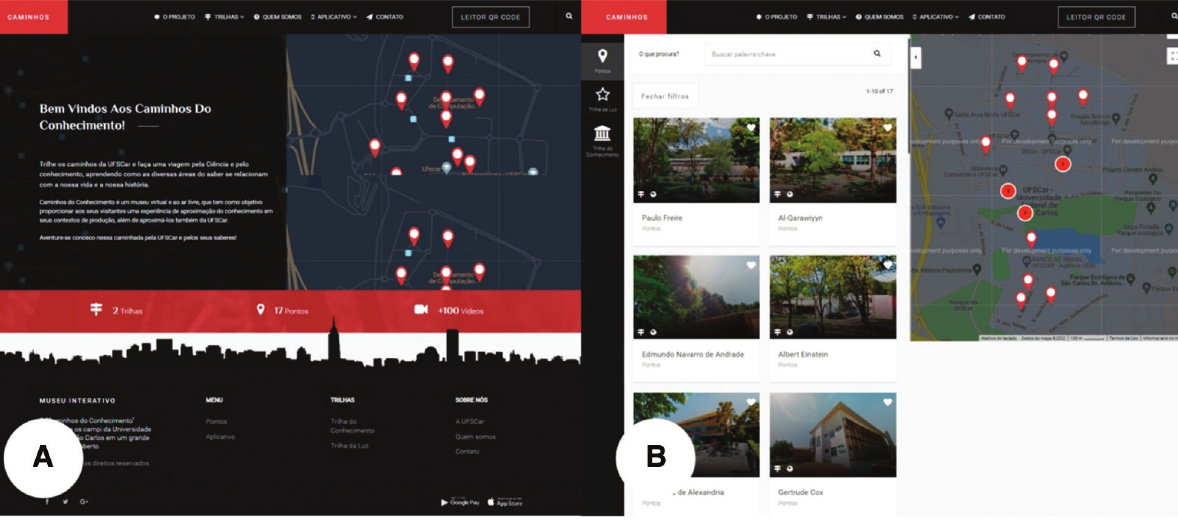
Figure 2. (A) Web platform home page (www.caminhos.ufscar.br); (B) Map indicating the location of points and paths through the university campus (Source: Authors,